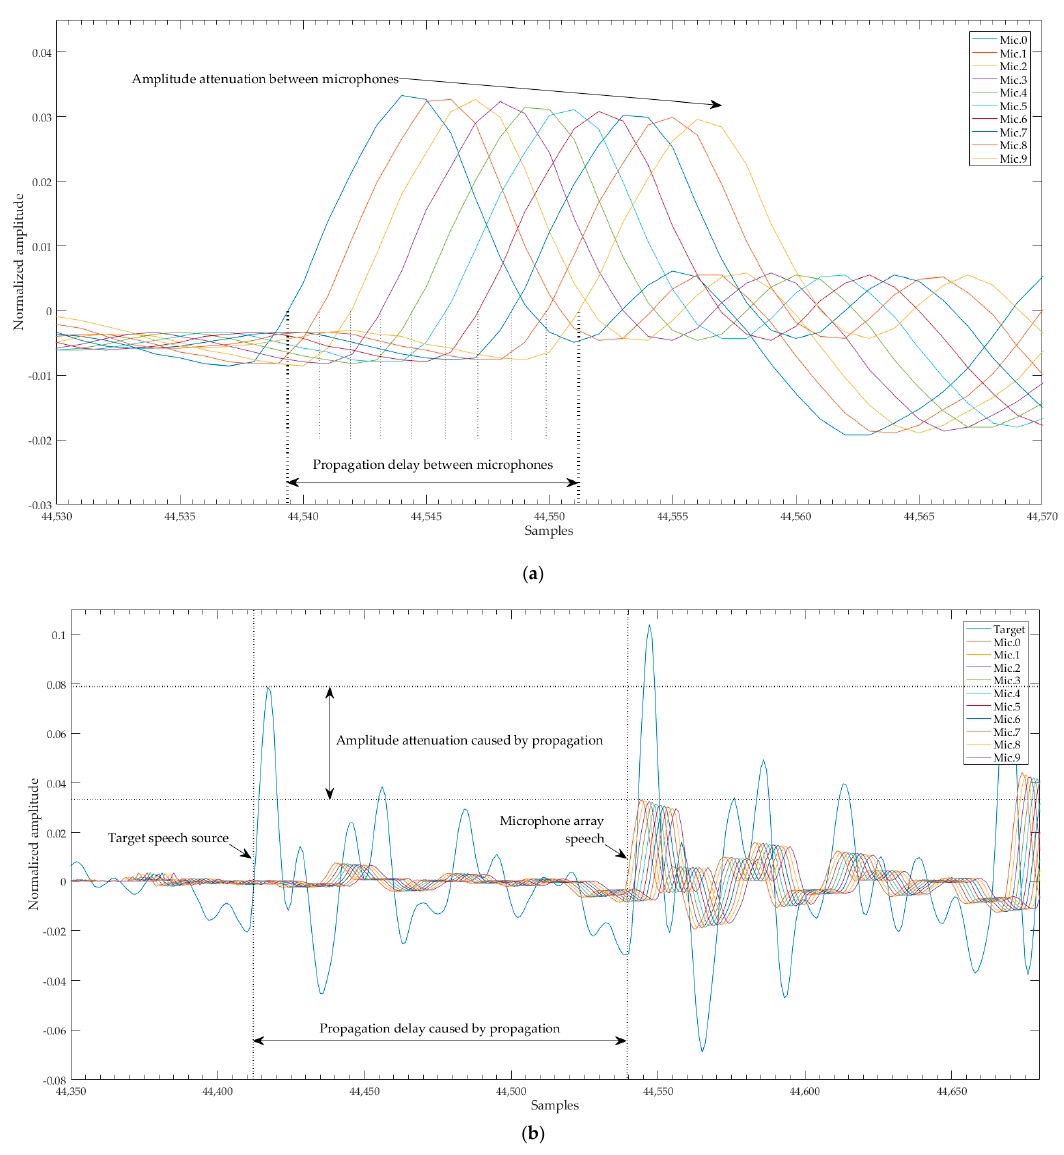
Figure 8. Time-domain waveform comparison; ( a ) clean speech signals of microphone array; ( b ) clean speech signals of microphone array together with the Target 1.